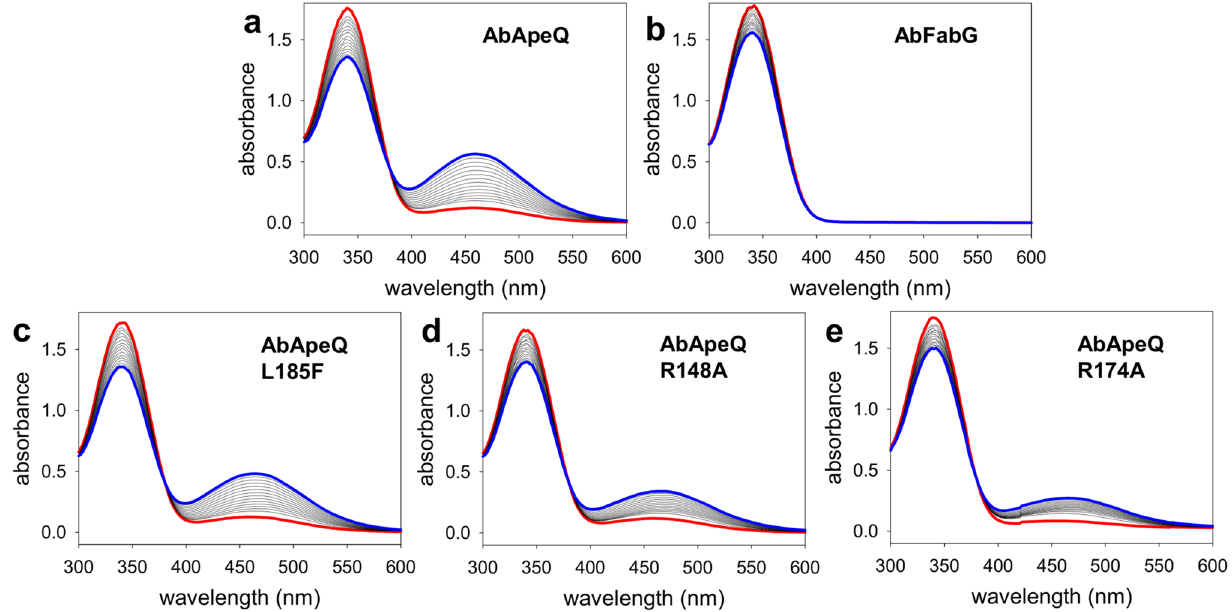
Figure 5. In vitro assay of APE biosynthesis. The cumulative spectrum of the in vitro APE biosynthesis product was recorded every 60 s over a period of 900 s. The initial and final spectra are rendered in thick red or blue lines, respectively, following the reaction with ( a ) AbApeQ, ( b ) AbFabG, ( c ) AbApeQ L185F, ( d ) AbApeQ R148A, and ( e ) AbApeQ